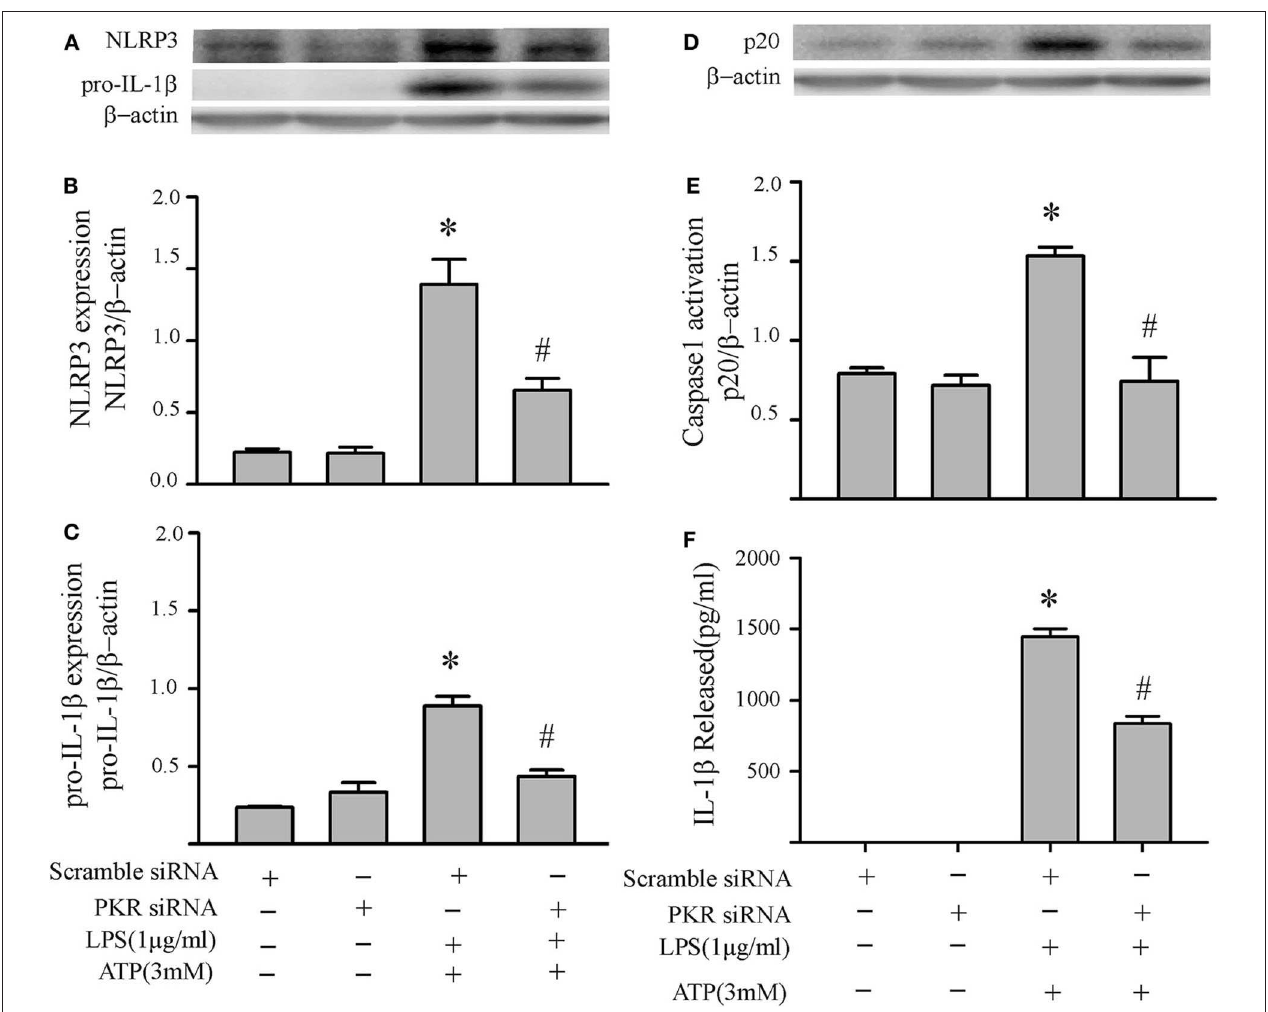
FIGURE 3 | Knock down of PKR by siRNA decreases NLRP3 inflammasome priming/activation in LPS/ATP challenged fibroblasts. Forty-eight hours after transfection with siRNA targeting PKR or scrambled RNA, the fibroblasts were challenged with LPS (1 µ g/mL) for 6h followed by ATP (3mM) for 30min. (A–C) NLRP3 and pro-IL-1 β protein levels were indices of inflammasome priming. Representative Western blots are shown in (A) and densitometric analyses in (B,C) . (D–F) Caspase 1 activation (p20) and release of mature IL-1 β were indices of inflammasome activation. Representative Western blot for caspase 1 p20 is shown in (D) and densitometric analysis in (E) . Protein levels of IL-1 β were assessed in supernatants by ELISA. n = 3, * p < 0.05 as compared with control; # p < 0.05 as compared with LPS +